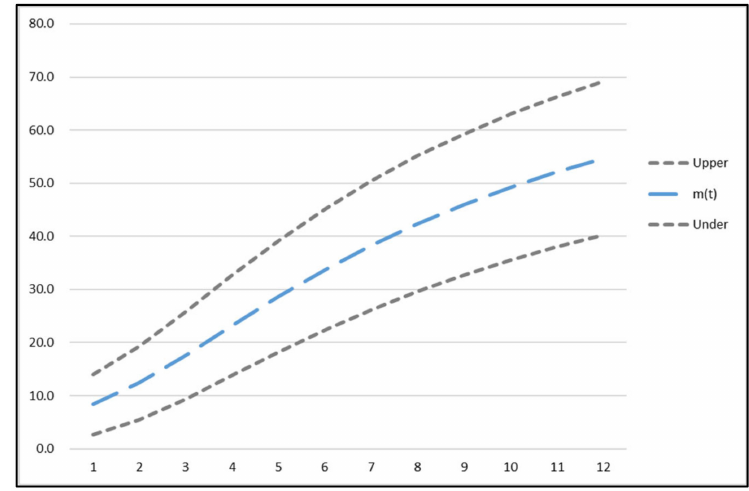
Figure 4. Confidence intervals (95%) of dataset 2.